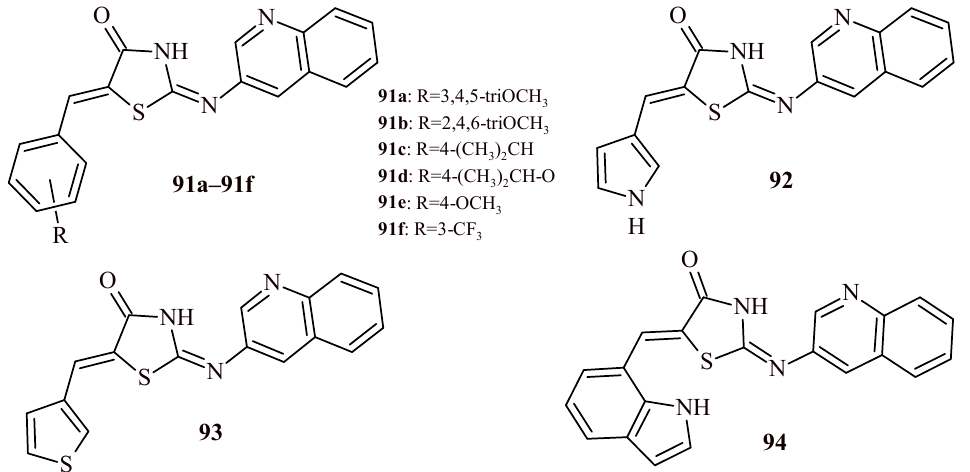
Figure 40. The quinoline-thiazolidin-4-one hybrids as inhibitor of methionine aminopeptidase 1 from Leishmania donovani .